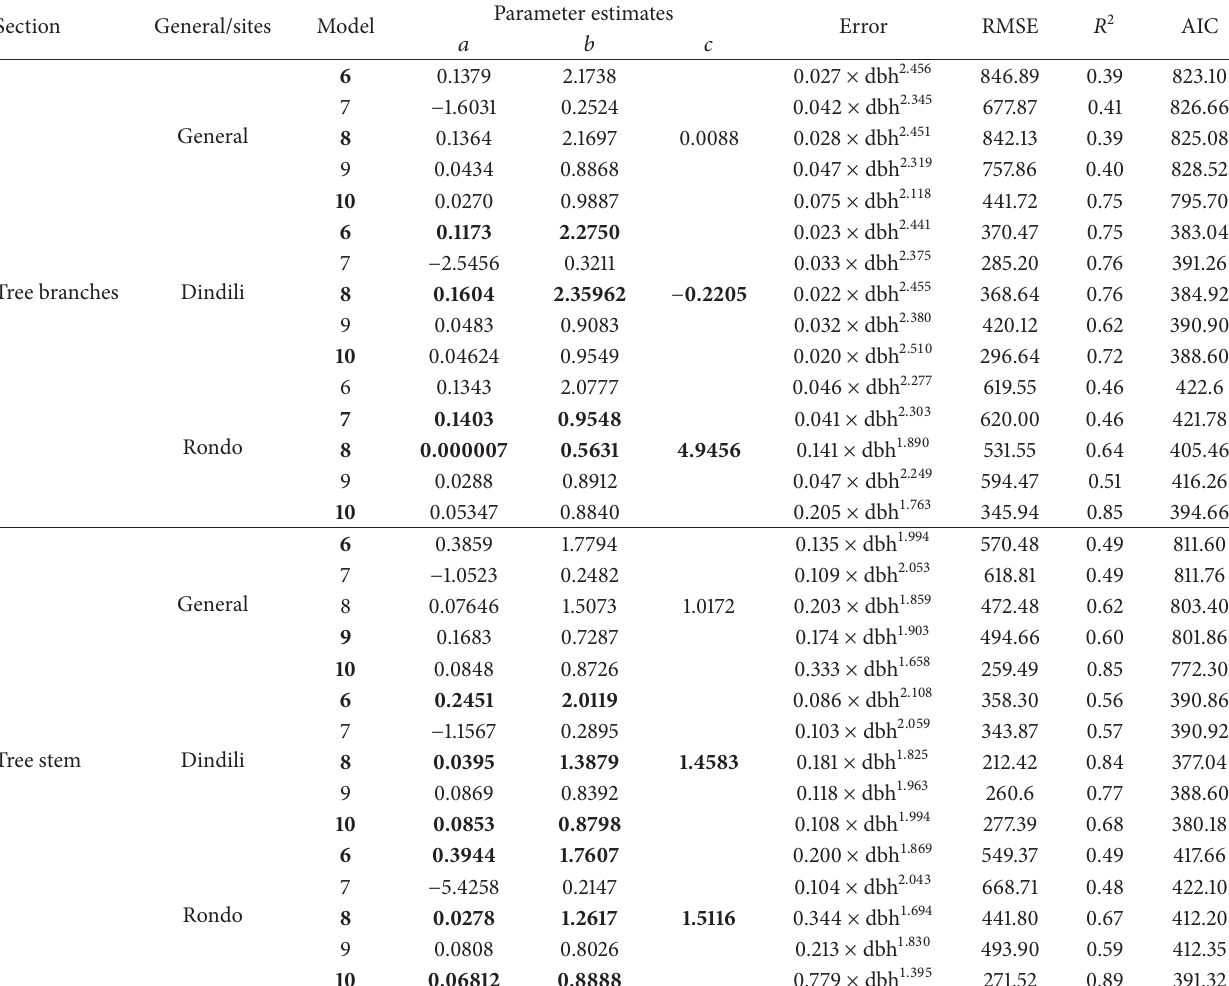
Table 6: Parameter estimates and performance of general and site specific models for biomass of tree sections. Section